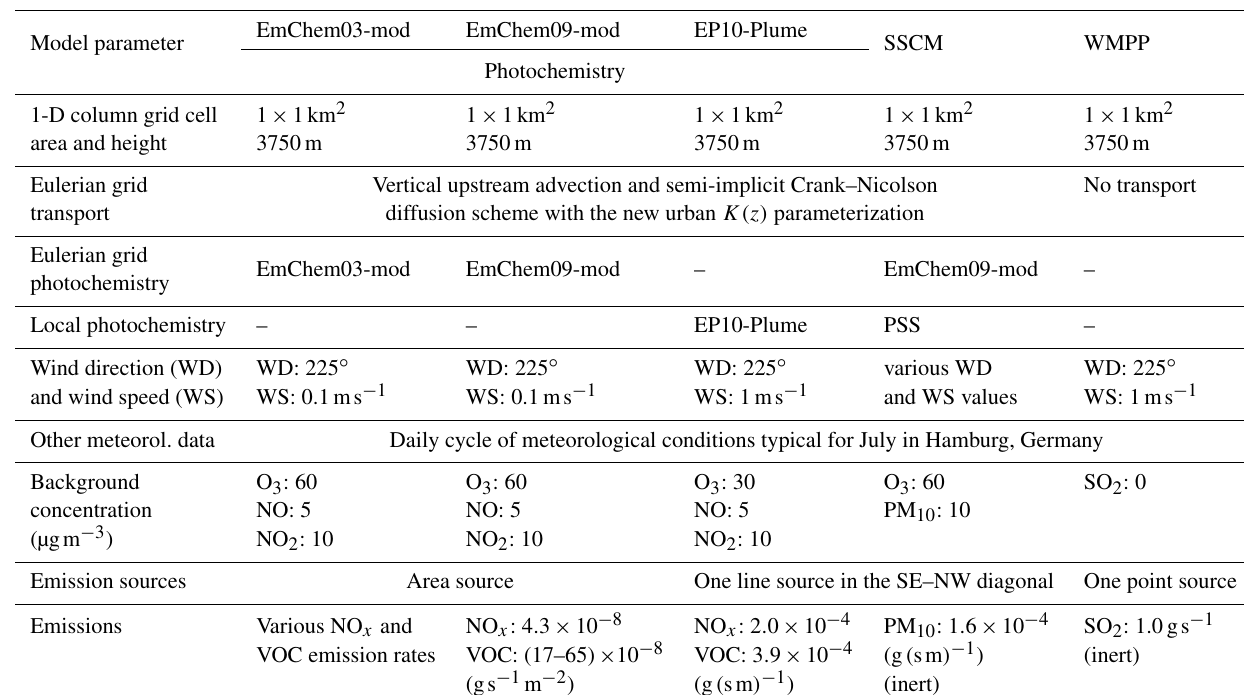
Daily cycle of meteorological conditions typical for July in Hamburg,